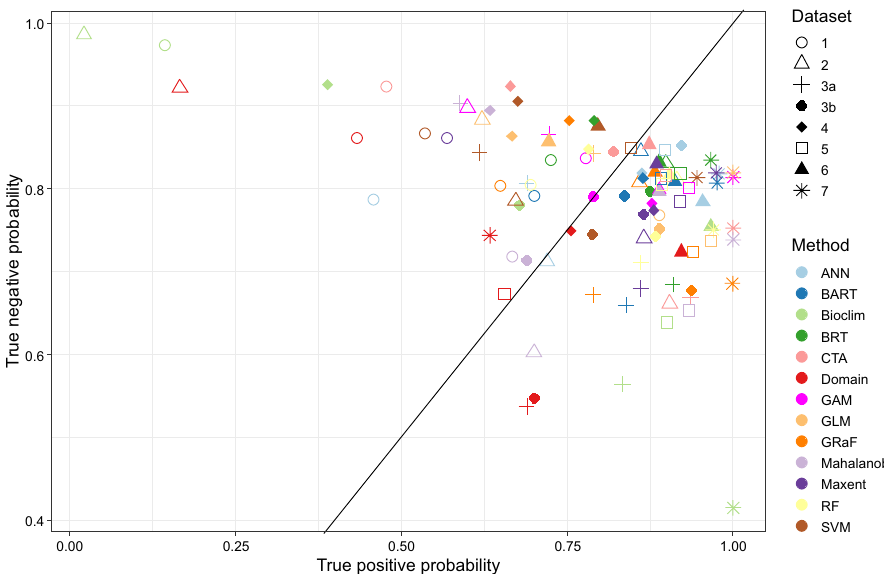
Figure 5. Estimates of true positive (TP) and true negative (TN) classification probability rates for different algorithms and datasets. TP and TN are derived from data collected in the field using a GPS device. The line shows where TP is equal to TN, i.e., the best model correctly classifying TP and TN should be placed in the upper-right corner of the graph.